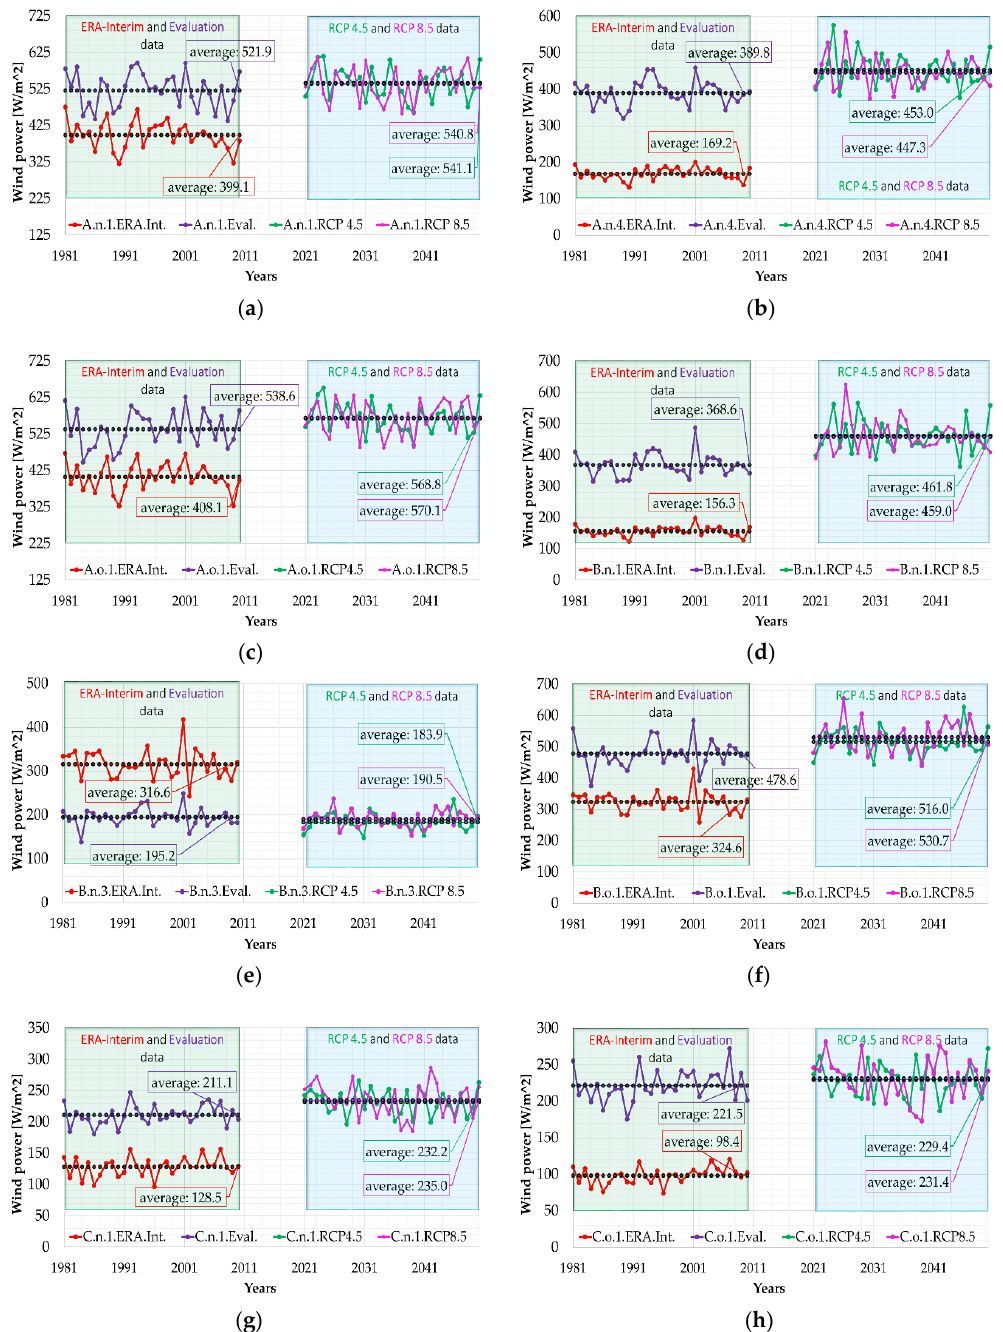
Figure 10. Annual wind power averages at 100 m height for 8 representative points: ( a ) A.n.1; ( b ) A.n.4; ( c ) A.o.1; ( d ) B.n.1; ( e ) B.n.3; ( f ) B.o.1; ( g ) C.n.1; ( h ) C.o.1.ERA.Int and Eval data, time interval 1981–2010; RCP4.5 and RCP8.5 data, time interval 2021–2050. For each dataset, the average of the wind power corresponding to the entire time interval is indicated in the box.